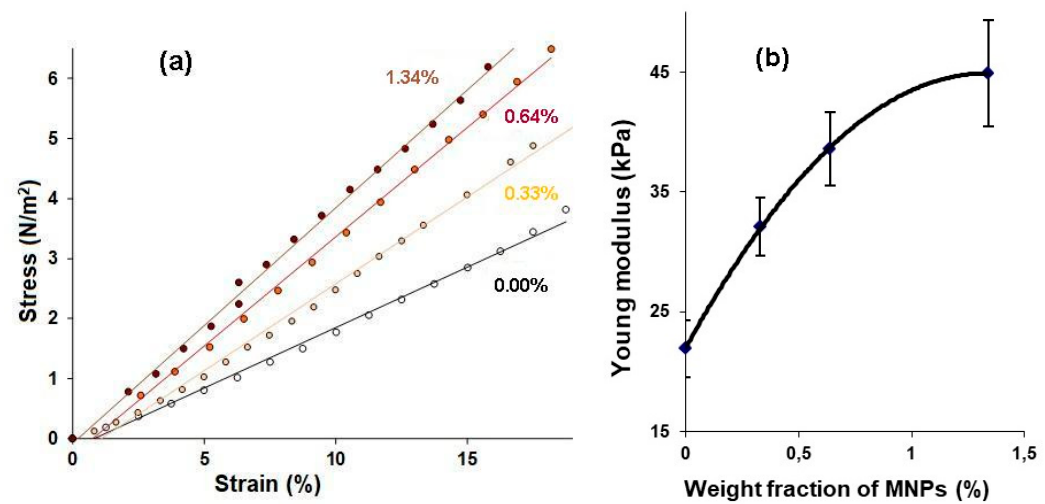
Figure 4. Example of the ‘stress-strain’ relationship for gels of batch #1 ( a ) and the dependence of Young’s modulus on the MNPs concentration in gels of batch #1 ( b ). Vertical bars reflect the confidence interval with p = 0.05. Following fit parameters were obtained for stress ( σ ). For concentration 0.00%: σ = 20.2 ε − 0.2, R 2 = 0.995. For concentration 0.33%: σ = 28.9 ε − 0.3, R 2 = 0.994. For concentration 0.64: σ = 36.4 ε − 0.3, R 2 = 0.997. For concentration 1.34: σ = 39.2 ε − 0.1, R 2 = 0.998.